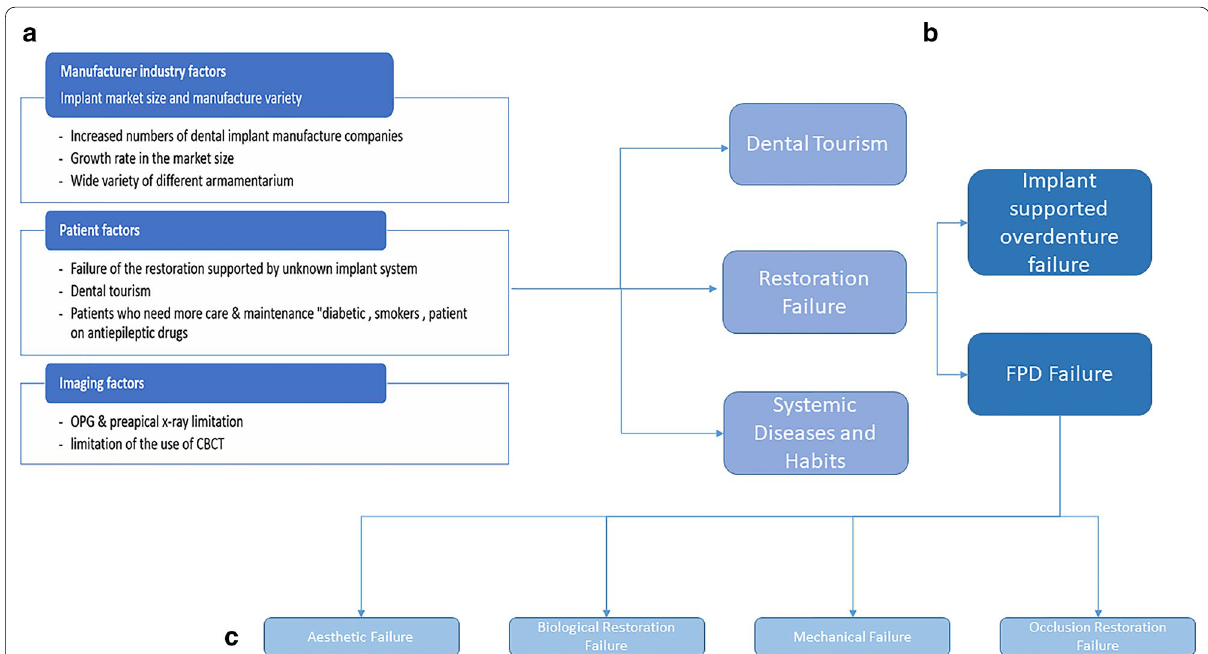
Fig. 2 a Summarization of the factors associated with the complexity of implant identification. b Distribution of patient factors. c The failure types of implant-supported